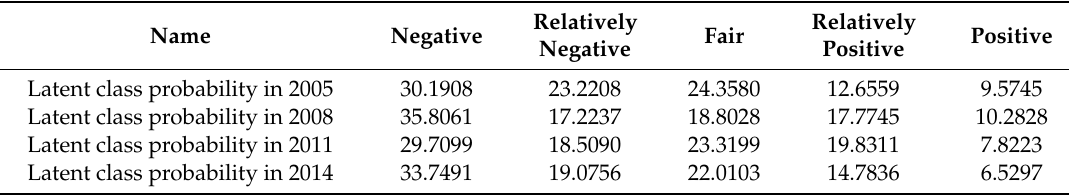
Table 4. Latent class probability of health behaviors in Chinese Elderly